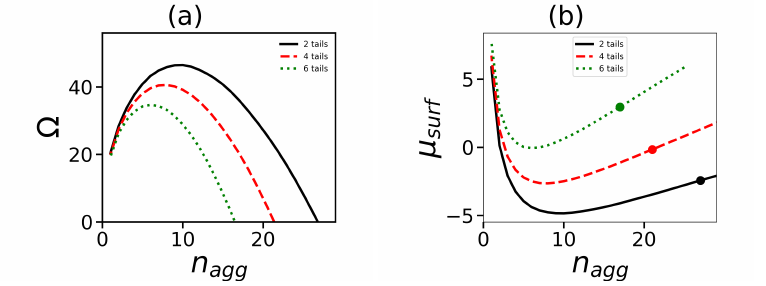
Figure 3. Dependencies of ( a ) the grand potential Ω ( n agg ) and ( b ) the chemical potential µ ( n agg ) at the same generation number G = 4, and the same overall number of hydrophobic segments in the surfactant N t · t = 120 ( t = 2, N t = 60; t = 4, N t = 30; t = 6, N t = 20). The dots in ( b ) show the values of µ surf where Ω ( n agg ) = 0.